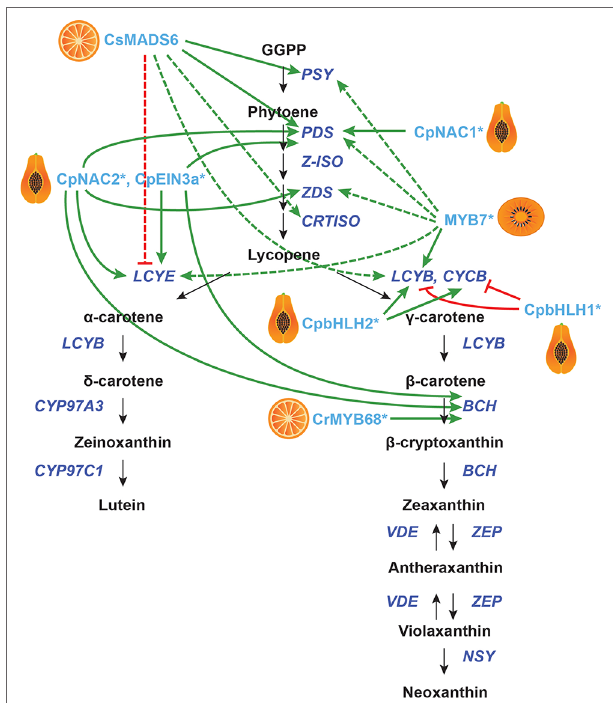
FIGURE 4 | Transcriptional regulation of CBP genes in other fruits. The regulation of CBP genes in citrus, peach, papaya, and orange kiwi. The carotenoid biosynthesis pathway is shown in black, with carotenoid biosynthesis genes indicated in dark blue. Carotenoid regulators discussed in the paper are shown in light blue. Green arrows indicate positive regulation, while blunt red arrows indicate negative regulation. Solid lines show direct interactions, while dotted lines show indirect/unknown